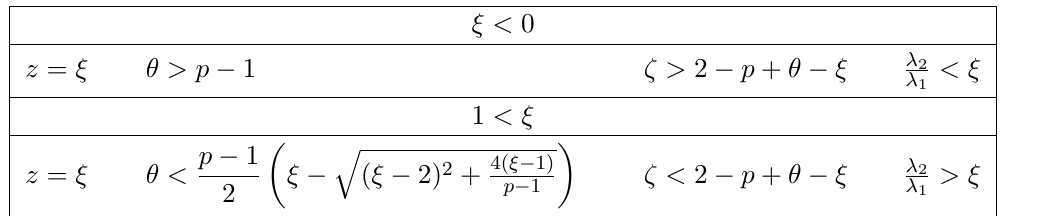
Table 4. Parameter range: Class I-ii, V 0 > 0.